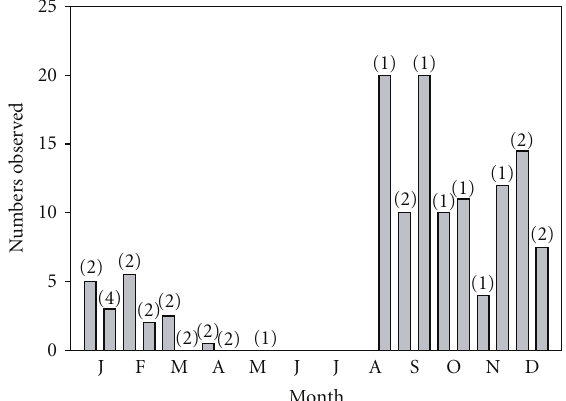
Figure 2: Numbers of adult J. genoveva observed flying along a 0.5km route at Estero del Soldado averaged over two-week intervals (see Figure 1(b)). The number of observations made during each interval is shown in parentheses. Data were not taken during the first two weeks of May, or from June to